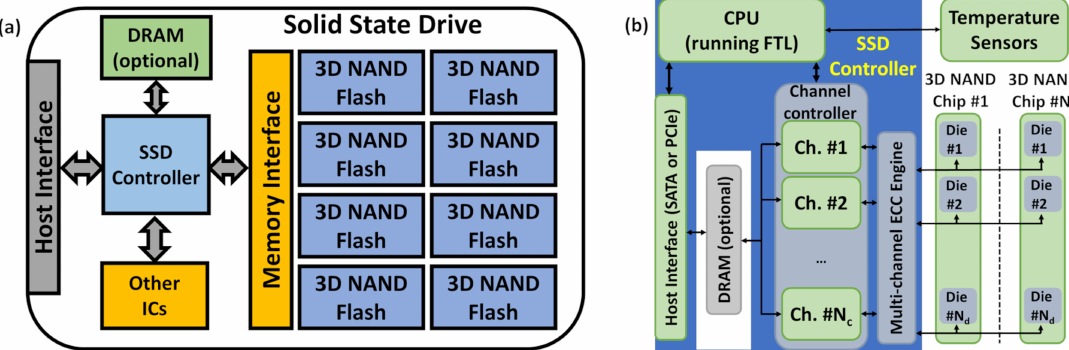
Figure 1. Layout of the components in an SSD ( a ) and an overview of its internal architecture ( b ). Reprinted with permission from [8] under Creative Commons License 4.0